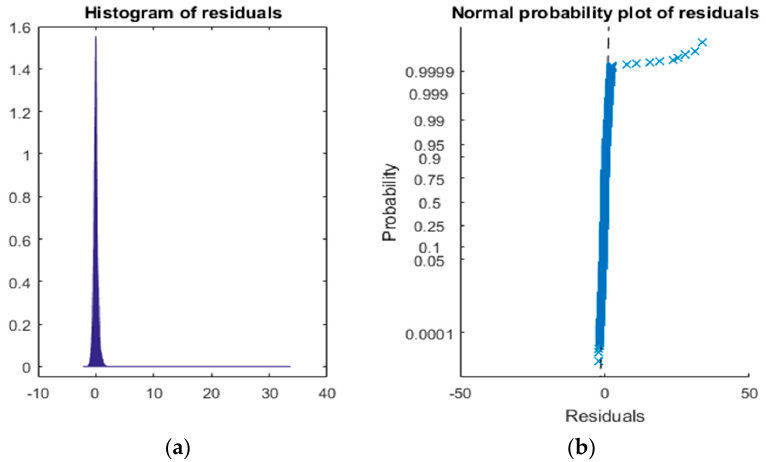
Figure 5. Plot of residuals for the linear model. ( a ) Histogram. ( b ) Normal Probability.